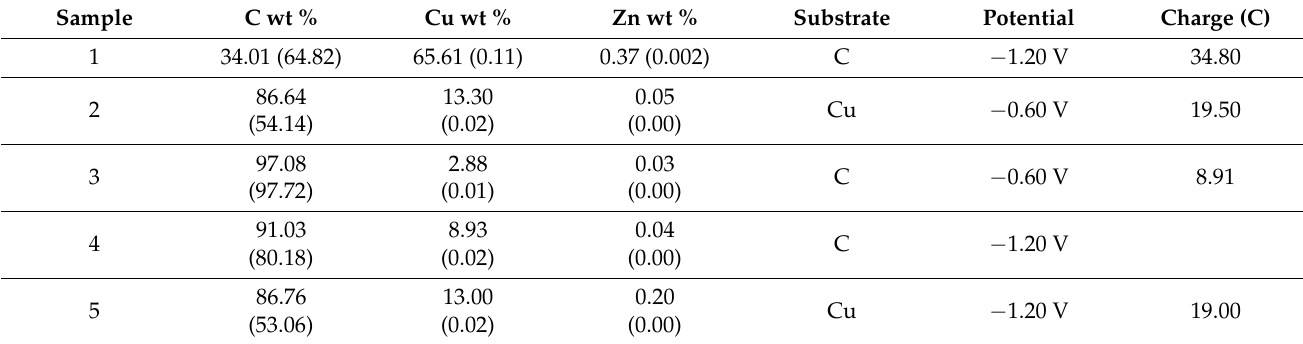
Table 4. Elemental analysis of the electrodeposited